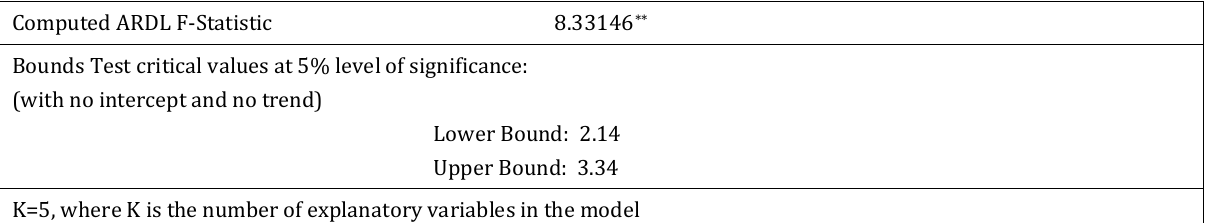
Table A1. Test Results of the long run relationships between the variables (source: author’s estimations) Computed ARDL F-Statistic